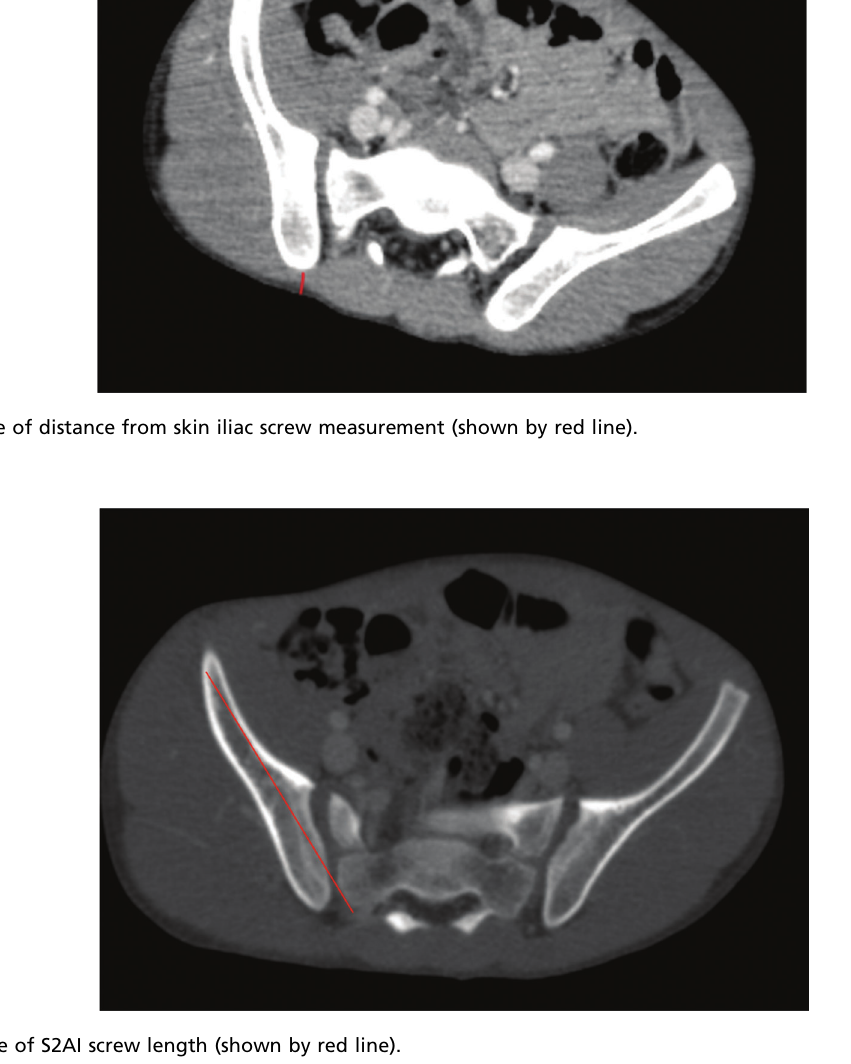
Figure 4 - Example of S2AI screw length (shown by red line).